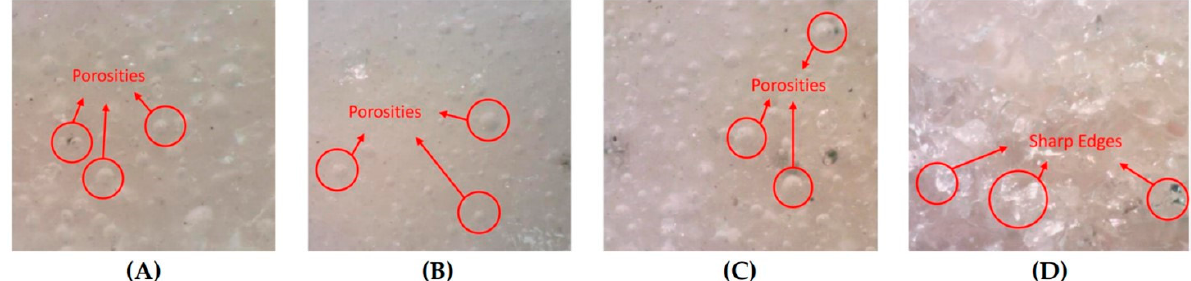
Figure 12. Amplification ( ~80 ×) of the fracture surface of representative specimens. Photos obtained with an AM7025X Dino-Eye eyepiece camera mounted on an Optika SZM trinocular stereo microscope. ( A ) Specimen 1h. ( B ) Specimen 8h. ( C ) Specimen 8v. ( D ) Specimen 20%h.